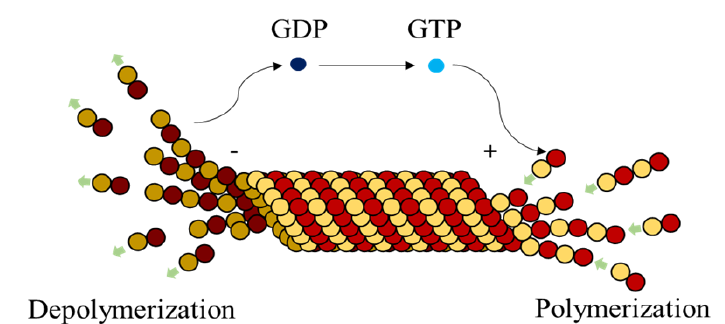
Figure 2. Active dimers associated with Guanosine-triphosphate (GTPs) polymerize to form microtubules (MTs). Simultaneously, GTPs associated with dimers hydrolyze to Guanosine-diphosphate (GDPs) leading to depolymerization